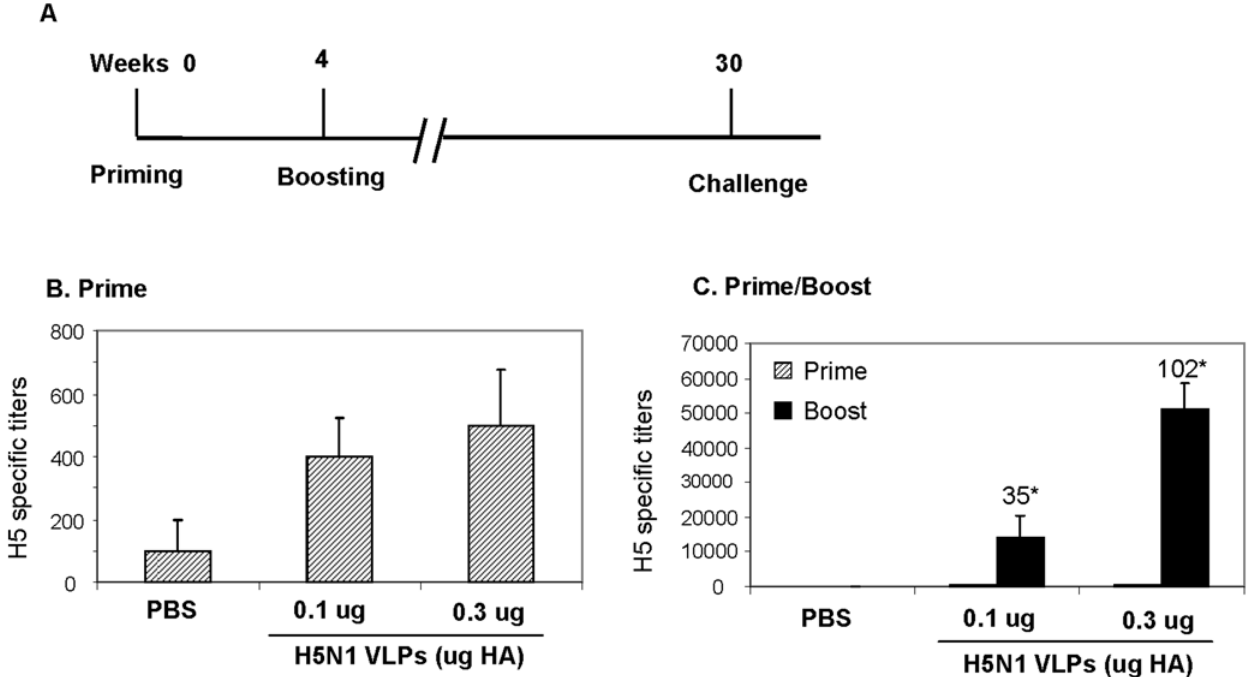
Figure 2. H5N1 Influenza virus specific total serum IgG antibody responses. A) Timeline for immunization and challenge. B) Influenza H5N1 virus specific serum IgG antibody titers at two weeks after priming by ELISA. Groups of mice (n=6) were intranasally immunized with H5N1 VLPs (0.1 m g and 0.3 m g of HA as indicated). PBS is a mock control group of mice mock-immunized with buffer only. C) Serum IgG antibody titers to inactivated rg D H5N1 influenza virus by ELISA at 2 weeks after boost immunization. Error bars indicate standard deviation. 0.1 m g HA and 0.3 m g HA indicate groups of mice immunized with H5N1 VLPs containing 0.1 m g and 0.3 m g of H5 HA respectively. * Fold increases in virus-specific antibody titers as compared to levels after